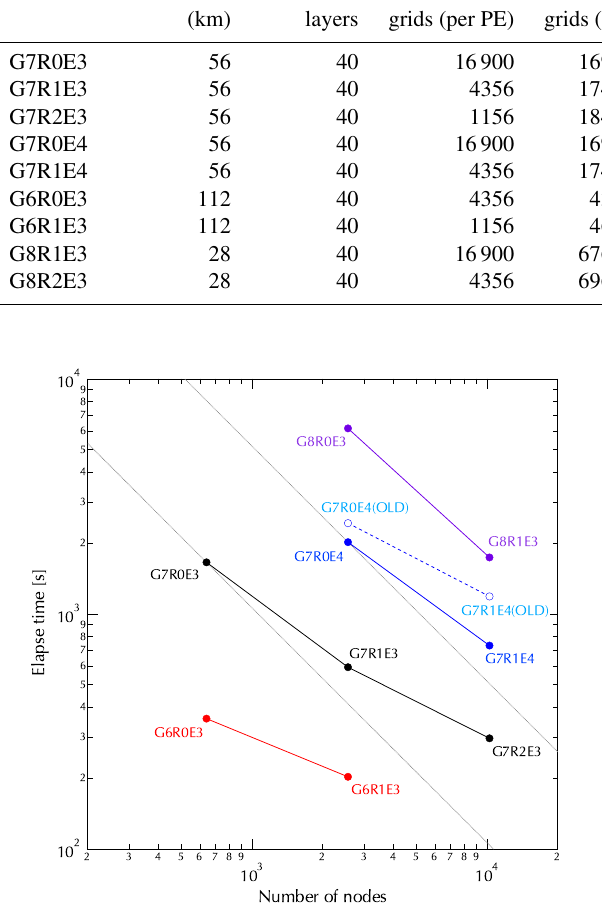
Figure 5. The time taken by NICAM–LETKF on the new frame-